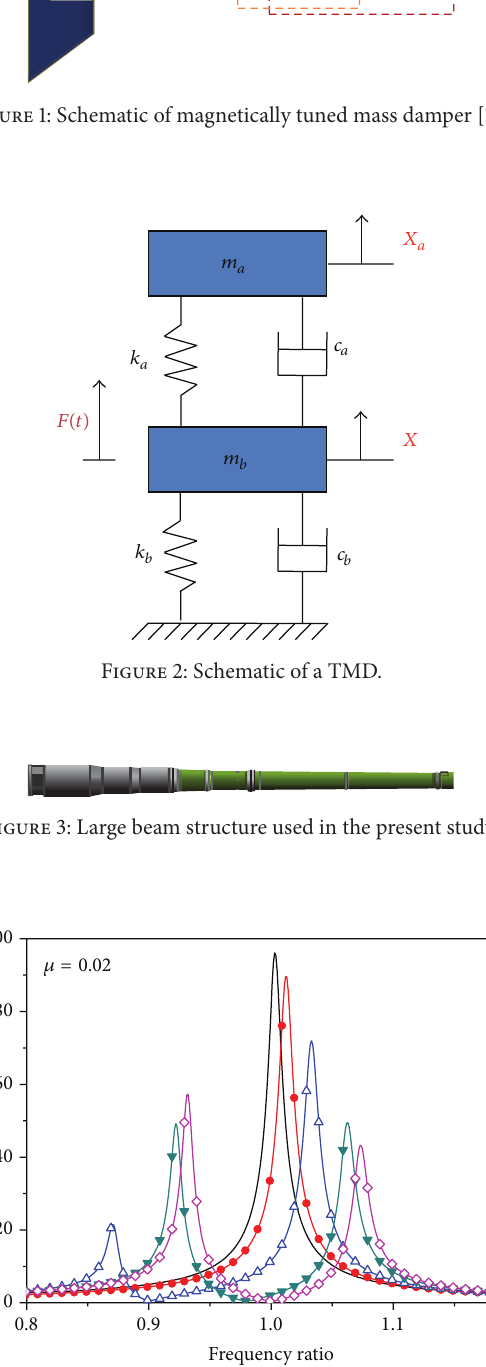
Figure 4: Normalized magnitude of the primary structure for vari- ous 𝛽 and 𝑟 .